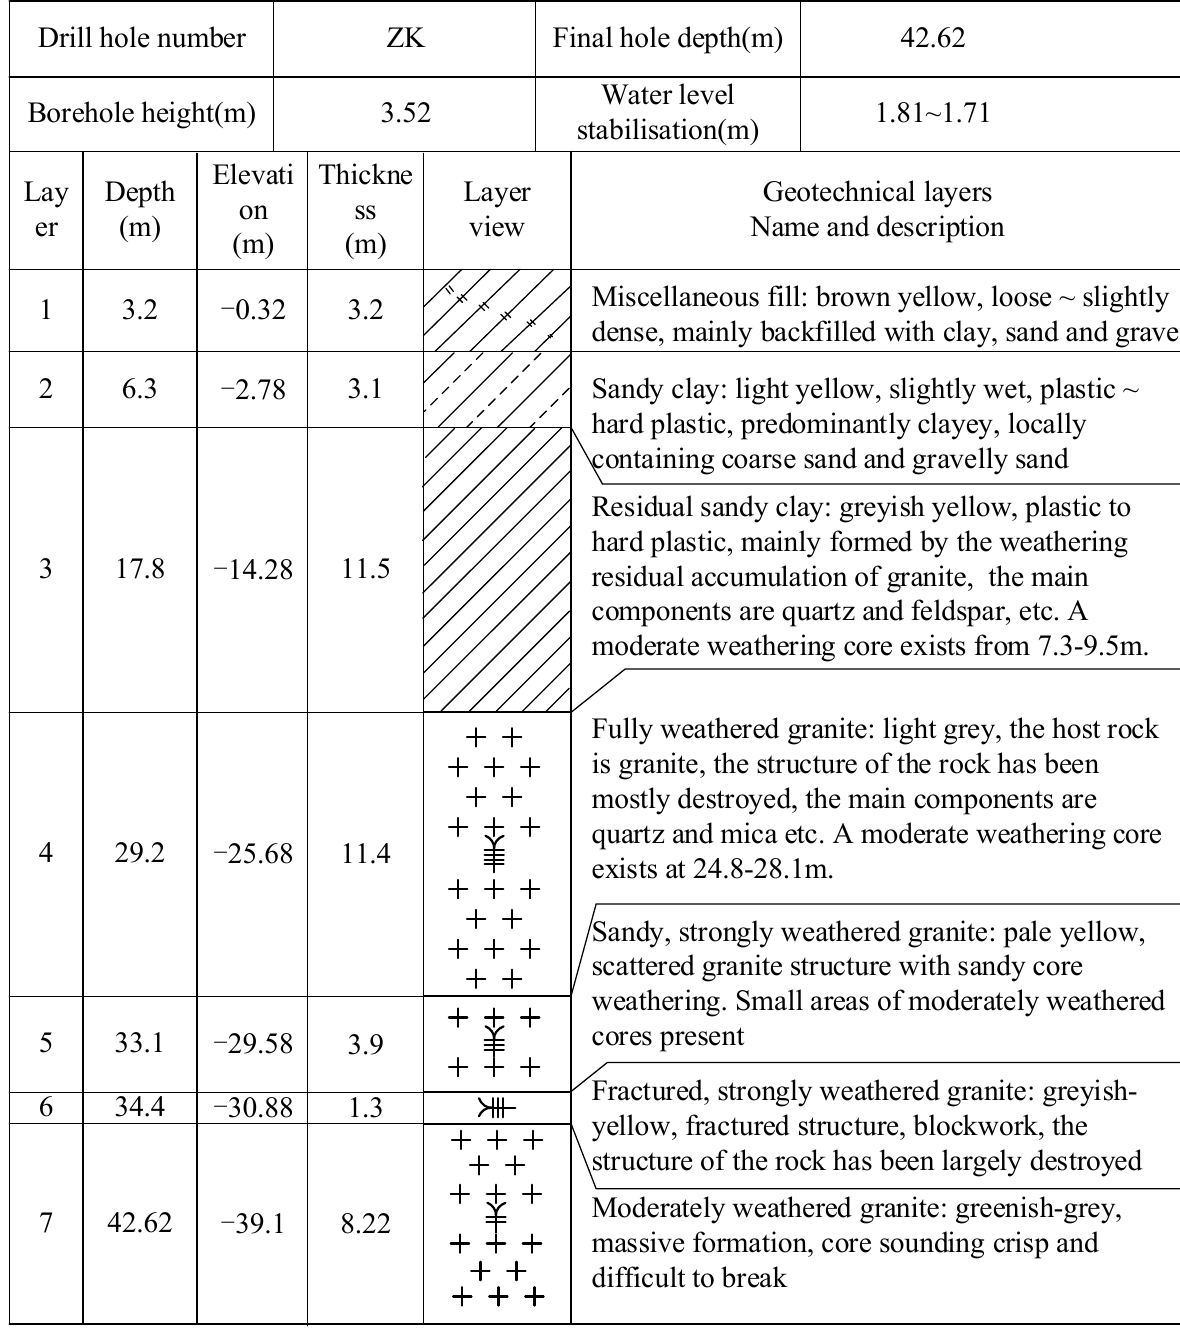
Figure 16. The engineering borehole drilling